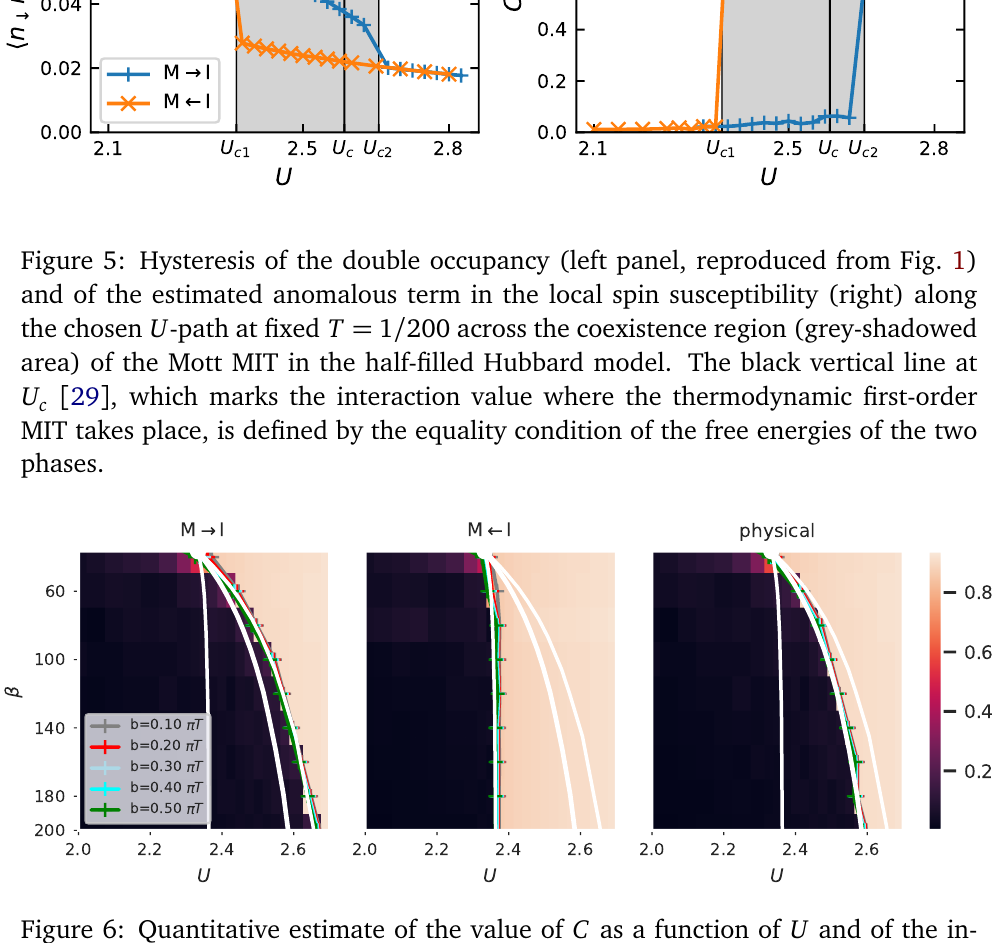
Figure 6: Quantitative estimate of the value of C as a function of U and of the in- verse temperature β along the whole coexistence region of the Mott MIT. The first two panels encode the results obtained along paths of the kind M → I (left panel), M ← I (central panel), while the rightmost panel provides the same estimates for the thermodynamically stable phases. The colored lines show the ( U , β ) tuples at which the fit loss min χχ 2 ( b ) starts to rise steeply. (Marked as squares in the right part of Fig. 11.) width b for the blurring of the regular part of the spectrum is set. All the lines associated with different values of b shown in the three panels of Fig. 6 collapse to the corresponding transition ( T ) , U ( T ) and U ( T ) ), confirming the lines of the calculation considered (respectively: U c 2 c 1 c emergence of detectable long-term memory effects in the local spin response only after crossing the first-order